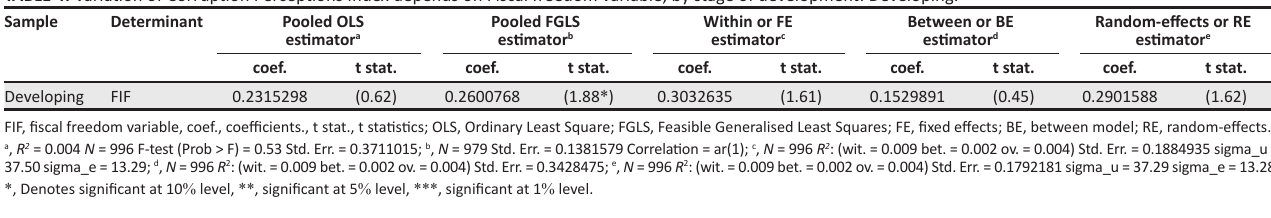
TABLE 4: Variation of Corruption Perceptions Index depends on Fiscal freedom variable, by stage of development: Developing. Sample Determinant